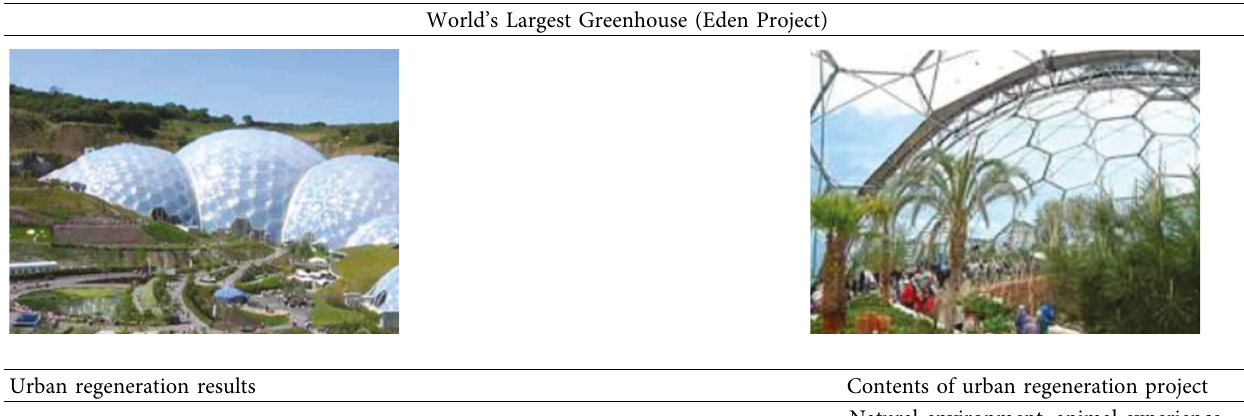
Table 2: Result of urban regeneration for Eden Project in the United